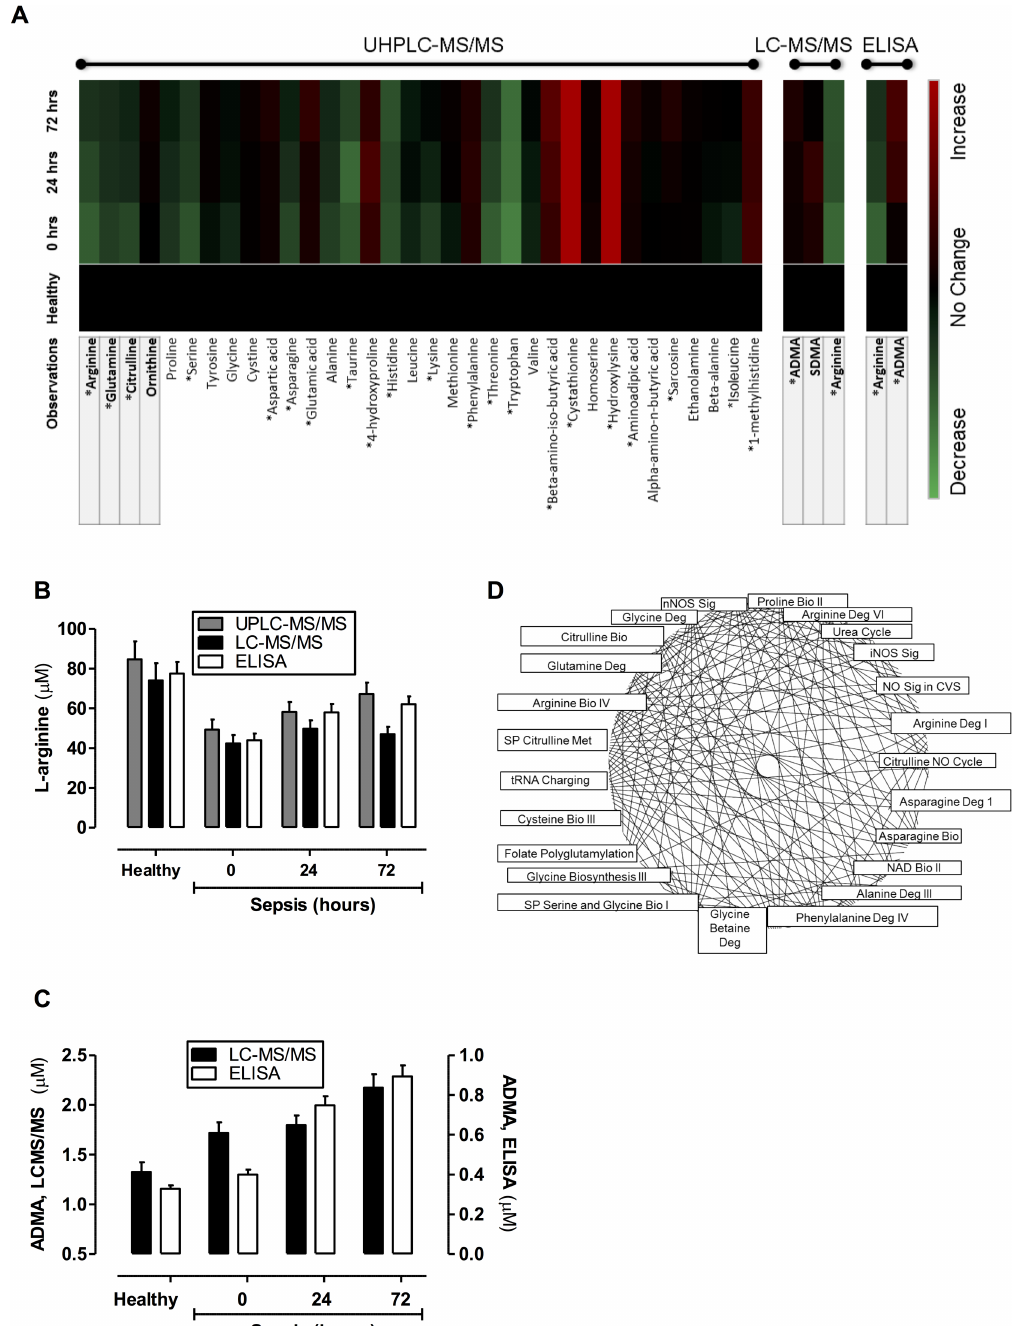
Fig 1. Targeted metabolic profiling of amines and methylarginines in human plasma from healthy donors and patients with sepsis. Amine and methylarginine levels were measured using (A) UHPLC-MS/MS, LC-MS/MS and/or ELISA in the plasma of healthy donorsand patients with sepsis at diagnosis (0 hours), 24 hours and 72 hours post diagnosis. Comparisonsbetweenlevels of L-argininefrom (B) UHPLC-MS/MS, LC-MS/MS and ELISA and (C) ADMA from LC-MS/MS and ELISA are shown at diagnosis (0 hours), 24 hours and 72 hours, post diagnosis. (D) Canonicalpathways extracted from IPA software were basedon an input of read outs comparingplasma levels of amines in healthydonors and patients with sepsis as a ratio. Data are ± SEM for n = 21 healthydonors and n = 38 patients with sepsis. Data was analysedby one-wayANOVA with Dunnett’s post-hoc test and Benjamini-Hochberg test with a false discovery rate of 0.05; * p <